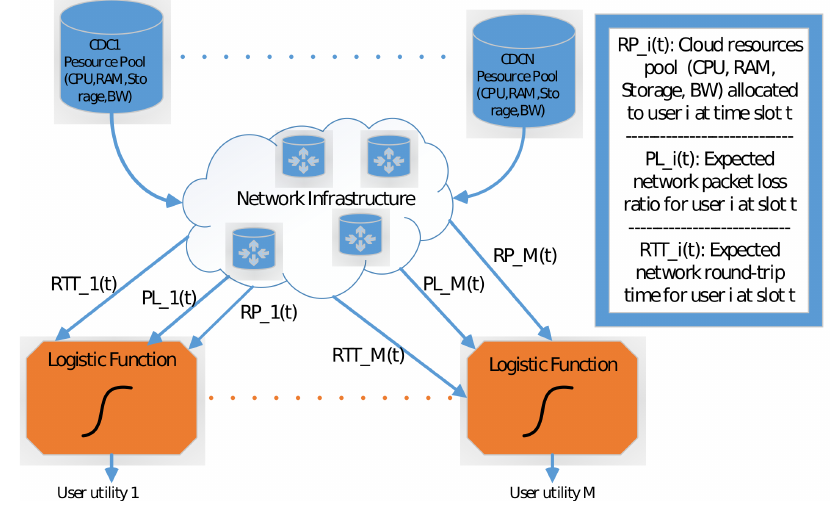
Figure 2. Flow diagram of calculating user utility